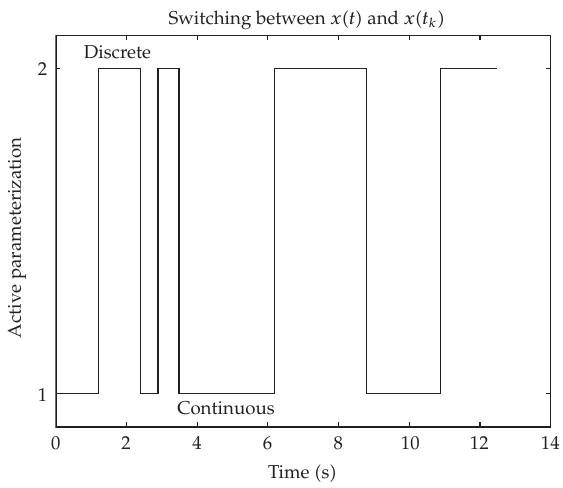
Figure 6: Switching between continuous-time and discrete control